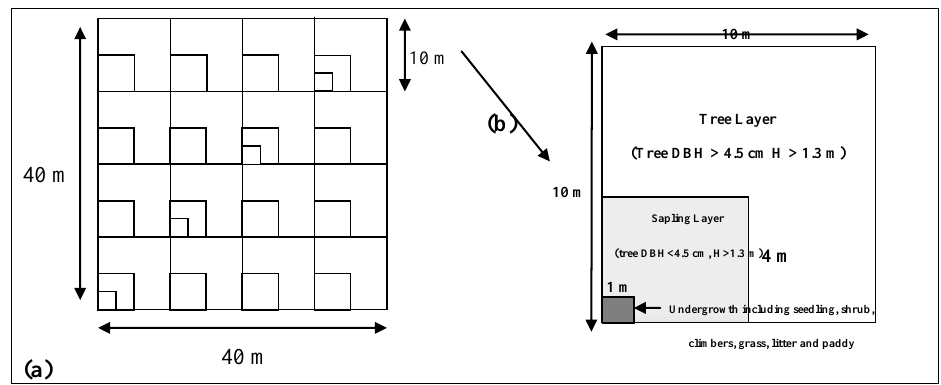
Figure 2. ( a ) The 40 × 40-m quadrat design; ( b ) nested quadrats for biomass diversity and Figure 2. (a) The 40x40-m quadrat design; (b) nested quadrats soil analysis. for biomass diversity and soil